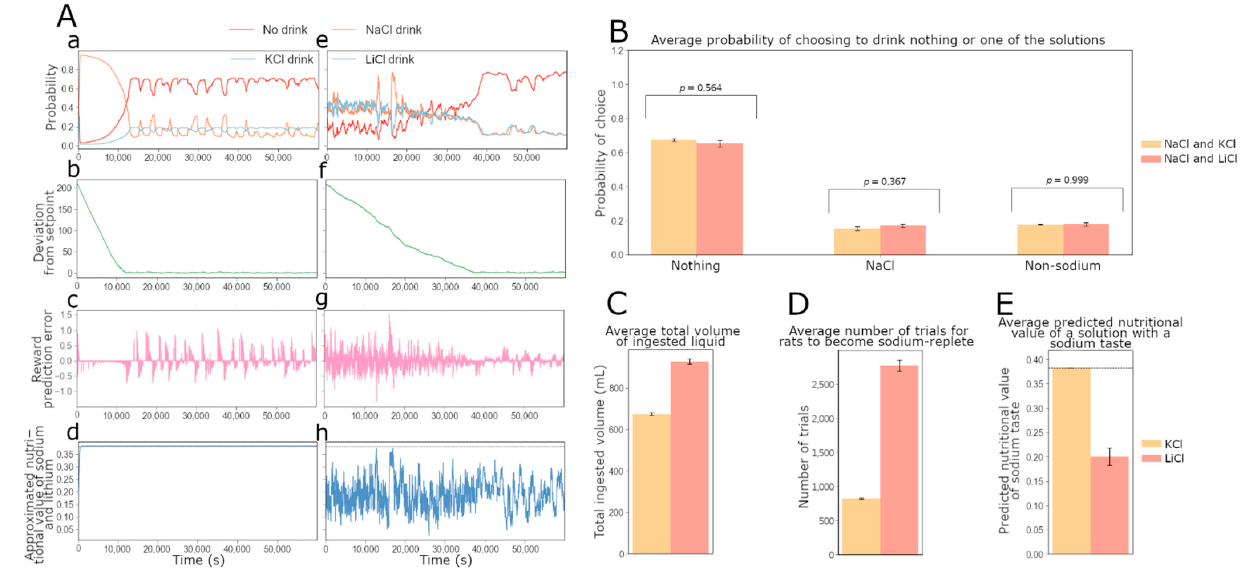
Figure 4. Model predictions for behavior during approach to sodium satiety. Here we produced example simulated data for two rats taking the two-bottle intake test developed by Fortin and Roitman (2018) for an extended period of time. In one version of the experiment, sodium-depleted agents have access to NaCl and KCl, and in the other version, NaCl and LiCl are the solutions available. Both versions of the experiment last 60,000 s (4000 trials). For panels in ( B ): 14 agents perform the version with KCl and 15 others perform the version with LiCl. The free parameter values for the agents in this group (N = 28) are all different and are sampled around the optimized ones used for the example data shown in ( A ). ( A ( a , e )) Evolution of the probability for an optimized agent to drink NaCl, KCl or nothing over time (left). Evolution of the probability for the same agent to drink NaCl, LiCl or nothing over time (right). ( A ( b , f )) Deviation from the optimal sodium state. The optimal level of internal sodium for survival is set at 0. ( A ( c , g )) Reward prediction error signals. ( A ( d , h )) Evolution of the approximated nutritional value ( ˆ K t ) for sodium ( d ) and lithium ( g ). ( B ) Average probabilities for agents (N = 28) to drink NaCl, the available non-sodium solution (KCl or LiCl) or nothing at the end of the 1000 min experiment. Probabilities for agents that have access to NaCl and KCl (N = 14) are shown in yellow, and probabilities for access to NaCl and LiCl (N = 15) are shown in red. ( C ) Average volumes of ingested liquid by agents (N = 28) during the 1000 min simulated experiments. The intake volume for agents that have access to NaCl and KCl (N = 14) is shown in yellow, and the intake volume for access to NaCl and LiCl (N = 15) is shown in red ( p = 1.39 × 10 − 11 ). ( D ) Average number of trials to reach the setpoint for sodium for the first time during the simulated experiments. The number of trials for agents that have access to NaCl and KCl (N = 14) is shown in yellow, and the number of trials for access to NaCl and LiCl (N = 15) is shown in red ( p = 1.27 × 10 − 11 ). ( E ), Average predicted nutritional value of sodium or lithium associated to their taste at the end of the 1000 min simulated experiments. This value for access to NaCl and KCl (N = 14) is shown in yellow, and for rats with access to NaCl and LiCl (N = 15) it is shown in red ( p = 4.45 × 10 − 7